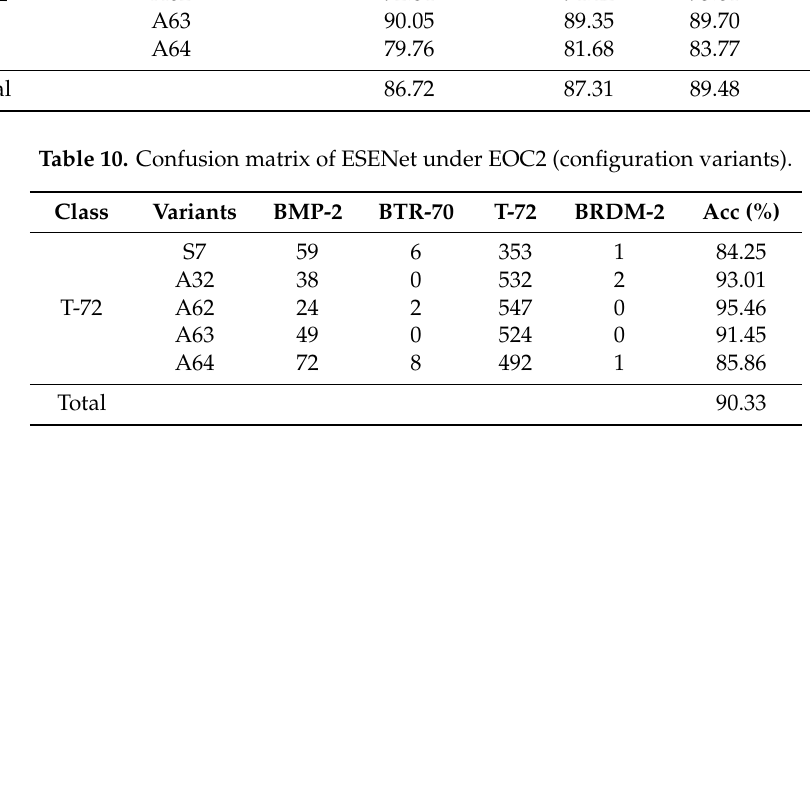
Table 10. Confusion matrix of ESENet under EOC2 (configuration